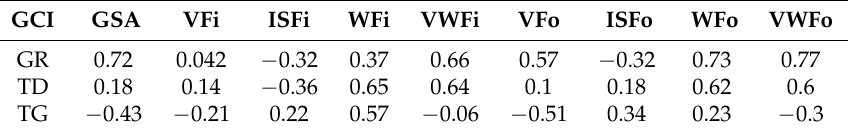
Table 10. Pearson’s correlation between impact factors and GCI indicators of Beijing. ISFi: impervious surface fraction within the green space boundary; ISFo: impervious surface fraction outside the green space boundary; VFi: vegetation fraction within the green space boundary; VFo: vegetation fraction outside the green space boundary; VWFi: combined effect of vegetation and water fractions within the green space boundary; VWFo: combined effect of vegetation and water fractions outside the green space boundary; WFi: water body fraction within the green space boundary; WFo: water body fraction outside the green space